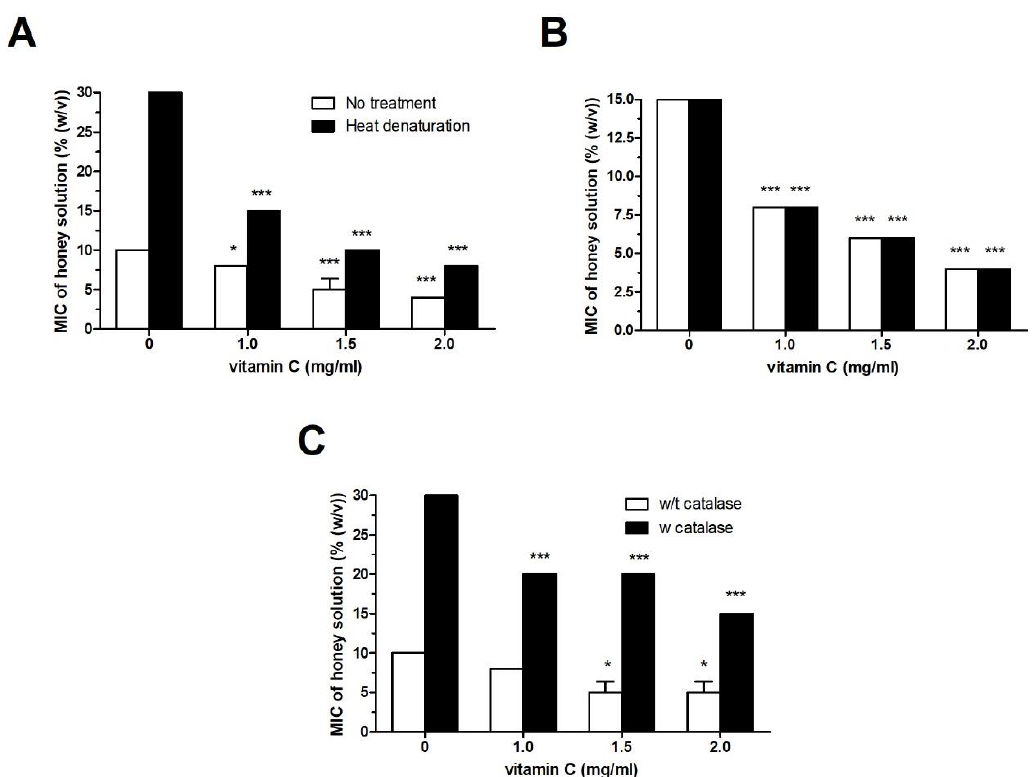
Figure 3. Antibacterial activity of honeydew and manuka honey samples before and after thermal treatment at 100 ◦ C for 5 min against Pseudomonas aeruginosa isolates. ( A ) honeydew honey and ( B ) manuka honey. Both honey samples were supplemented with Vit C after thermal treatment. ( C ) Honeydew honey was also subjected to catalase treatment, and the antibacterial activity against P. aeruginosa was determined after its supplementation with Vit C at sub-inhibitory concentrations. The activity was determined with a MIC assay. The MIC was defined as the lowest concentration of honey solution (%) that inhibited bacterial growth. The data are expressed as mean values with standard deviations. * P < 0.05, and *** P < 0.001.